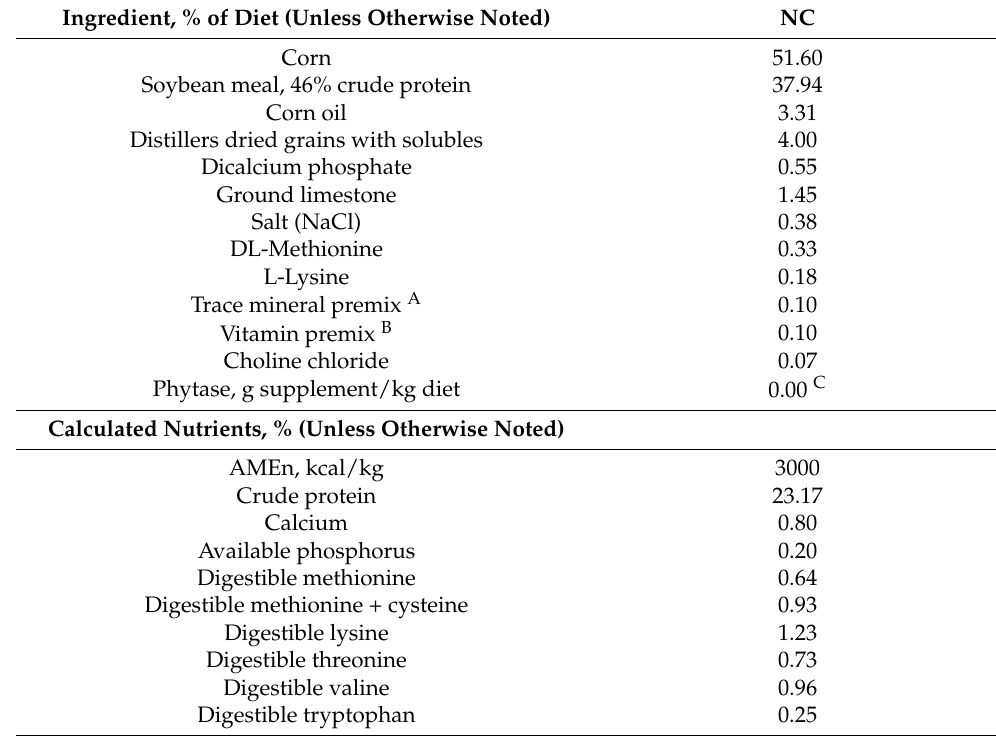
Table 1. Ingredient and analyzed nutrient compositions of the negative control (NC) diet (as-fed basis). Ingredient, % of Diet (Unless Otherwise Noted) NC Corn